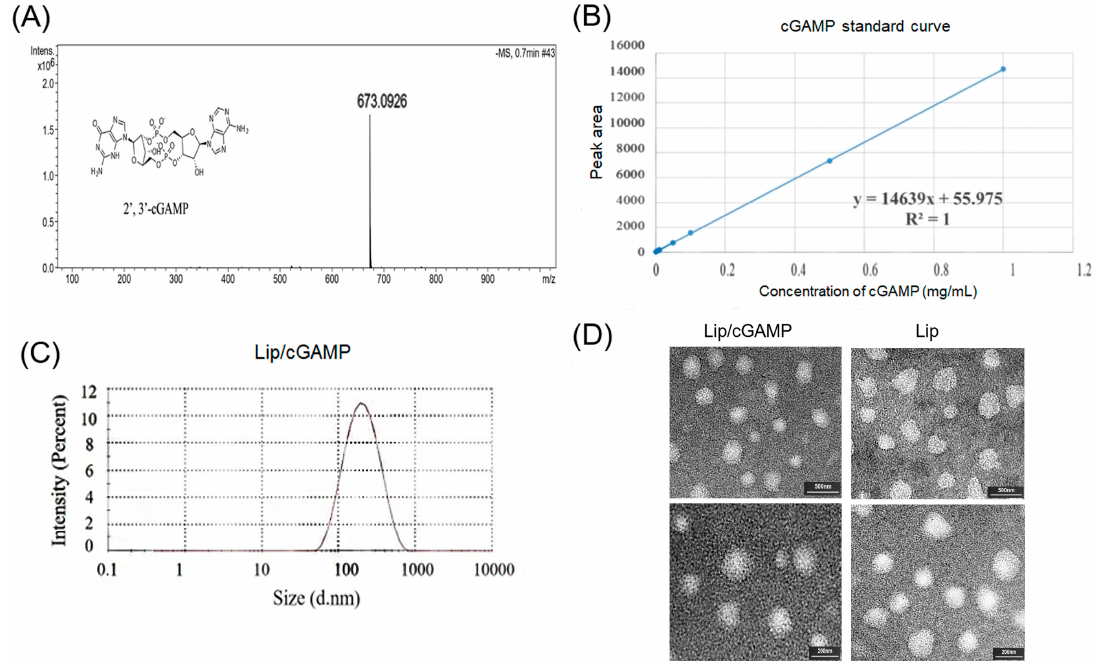
Figure 4. ( A ) The chemical structure and mass spectrum of the 2 ′ ,3 ′ -cGAMP molecule ( B ) The standard curve of cGAMP. ( C ) The particle size distribution of Lip/cGAMP. ( D ) The TEM revealing Lip/cGAMP and empty liposomes (Lip) with a uniform spherical shape (upper lane scale bars:500 nm, lower lane scale bars: 200 nm).